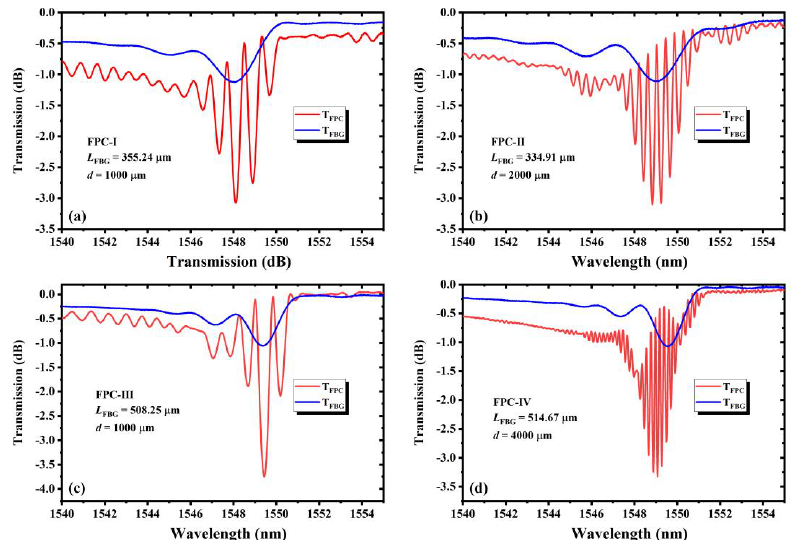
Figure 6. The transmission spectra of four line-by-line inscribed FBGs-based FPCs. ( a ) FPC- I: grating length 355.24 μm, cavity length 1000 μm; ( b ) FPC- II: grating length 334.91 μm, cavity length 2000 μm; ( c ) FPC- III: grating length 508.25 μm, cavity length 1000 μm; ( d ) FPC- IV: grating length 514.67 μm, cavity length 4000 μm.